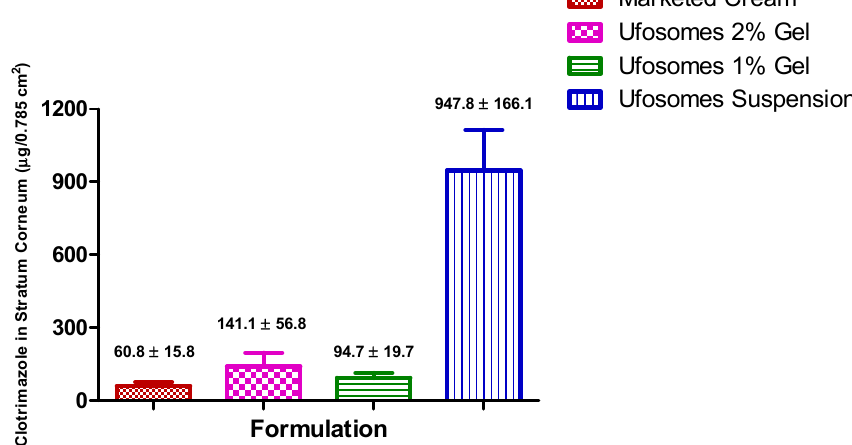
Figure 6. Amount of clotrimazole accumulated in stratum corneum-epidermis layers of skin. Data are represented as mean ± SEM ( n = 3).